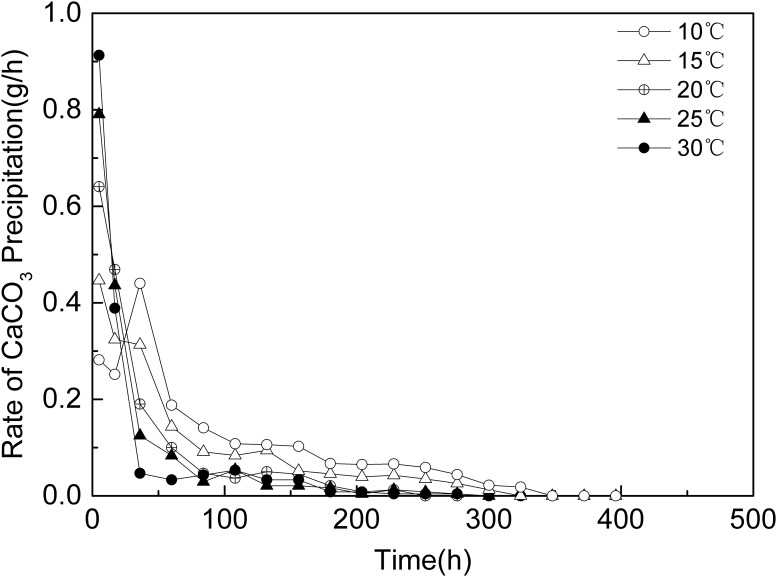
Rate of CaCO3 precipitation vs. time.